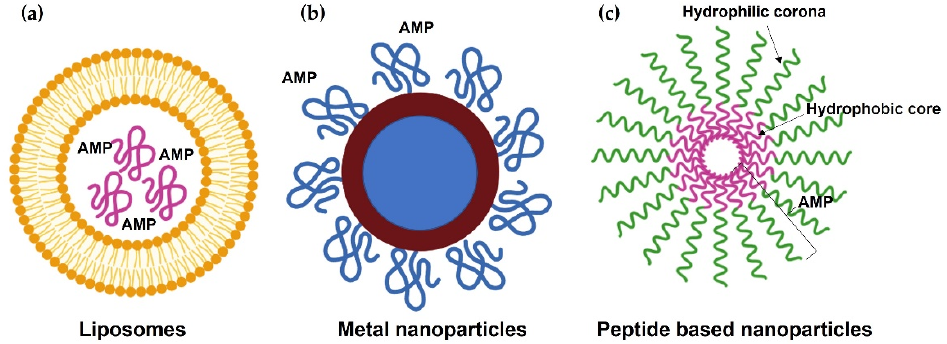
Figure 4. Delivery of antimicrobial peptides (AMPs) by nanoparticles. ( a ) Liposomal system for AMP delivery. ( b ) Metal-based nanoparticles for AMP delivery. ( c ) Self-assembling